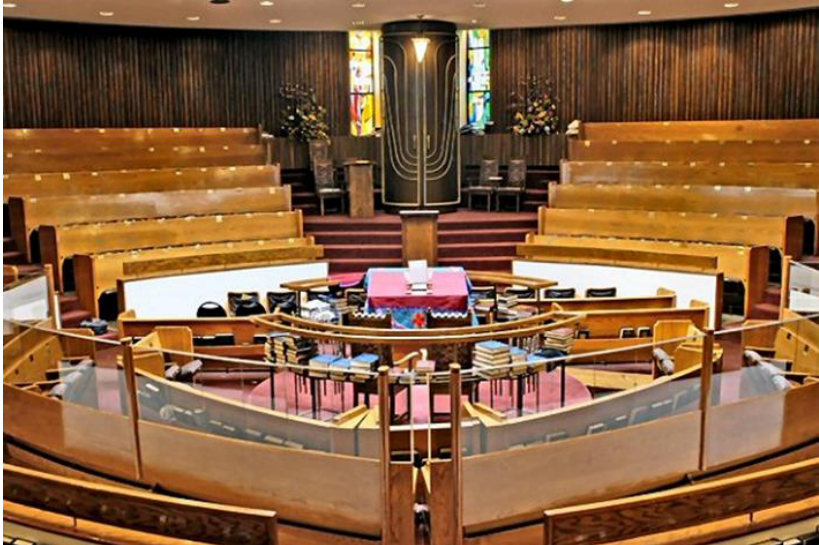
Figure 2. Lincoln Square Synagogue, 1966–70. Interior. Photo: jewishparentingguide.com No copyright infringement is intended.